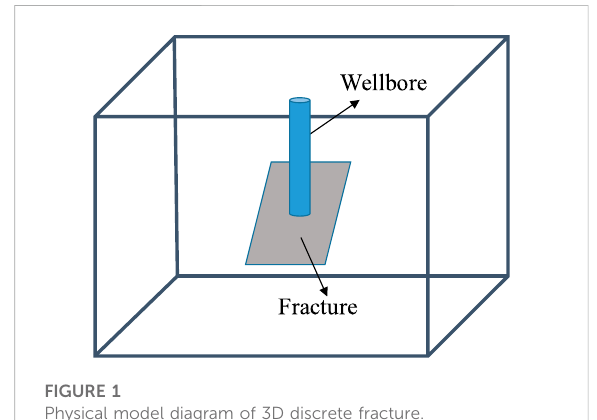
FIGURE 1 Physical model diagram of 3D discrete